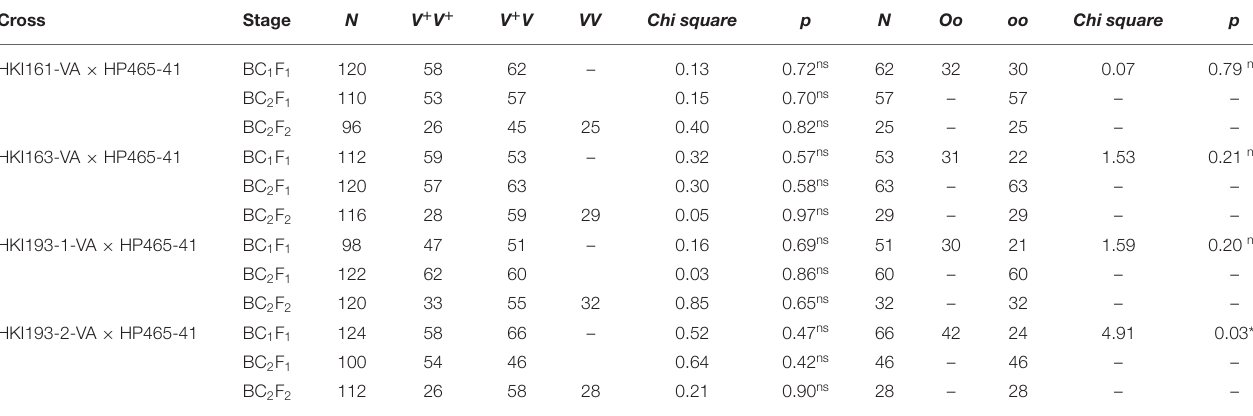
TABLE 1 | Segregation of vte4 and o2 genes in backcross generations. Cross